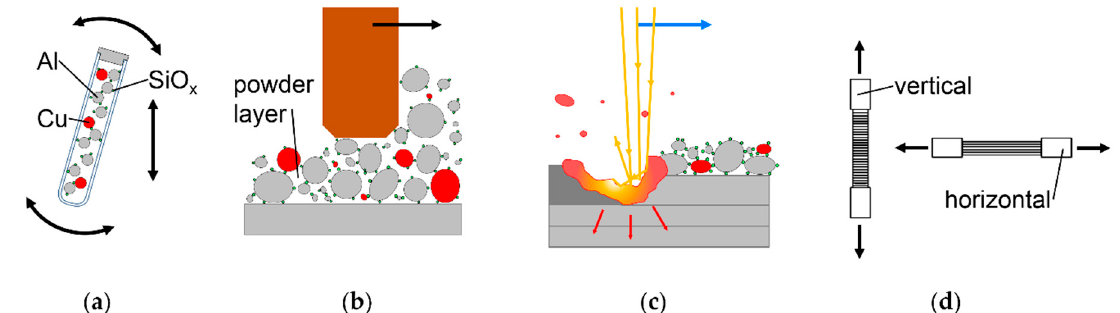
Figure 2. General methodology followed in this article; ( a ) evaluation of de-mixing in bulk powder with dry coated SiO x and varied PSD; ( b ) evaluation of de-mixing in thin powder layers inside LBM machine; ( c ) LBM experiments with micrographic analysis of relative density, ρ rel , defects, hardness and chemical homogeneity; ( d ) tensile tests of vertically and horizontally built specimens.